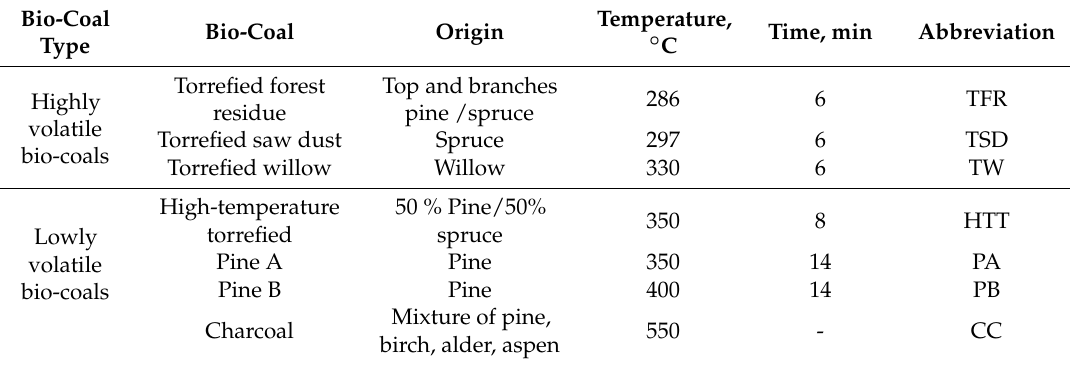
Table 1. Selected bio-coals with preparation temperatures and times.